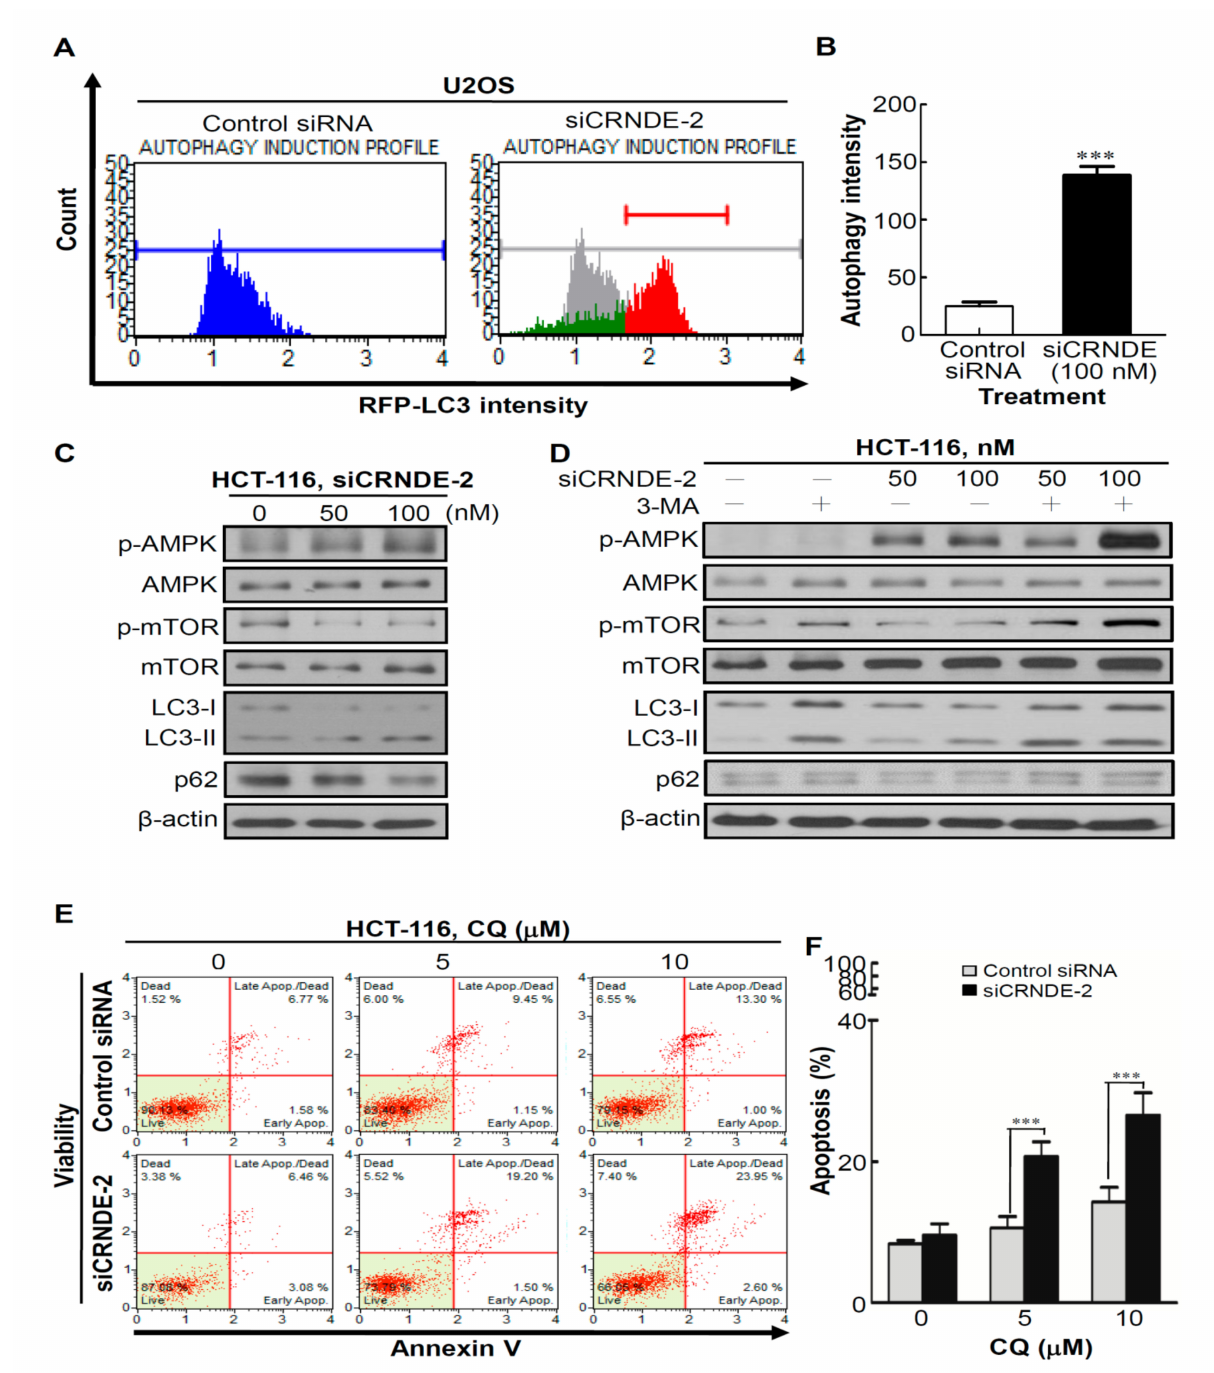
Figure 4. Colorectal neoplasia differentially expressed (CRNDE) is involved in regulating autophagy. ( A ) Small interfering (si) CRNDE-transfected red fluorescent protein (RFP)-LC3 reporter U2OS cells showed a shift in the histogram plot indicating autophagy induction (no autophagy in gray versus induced autophagy in red). ( B ) Quantification results of the autophagy intensity. ( C ) Western blot analysis of the effects of CRNDE-knockdown on adenosine monophosphate-activated protein kinase (AMPK) phosphorylation and its downstream targets, mammalian target of rapamycin (mTOR) and autophagy markers in HCT-116 cells. ( D ) Whole-cell lysates were prepared from HCT-116 cells co-treated with siCRNDE and 3-MA and immunoblotted with antibodies against AMPK, mTOR, and p62. ( E ) CRNDE was silenced for 48 h with 100 nM of specific siRNA, following which cells were treated with chloroquine (CQ; an autophagy inhibitor) at the indicated concentrations for an additional 48 h. Caspase-3/7 activities were measured with a Muse Cell Analyzer. ( F ) Quantification results of Annexin V-positive cells with CRNDE-knockdown alone or in the presence of CQ. *** p <